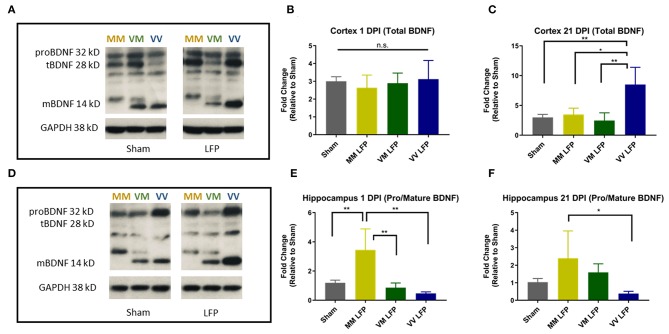
Repeated mild LFP injury causes an increase in proBDNF/mature BDNF expression in Met carriers compared to Val carriers in the hippocampus at 1 and 21 DPI. (A,D) Representative Western Blot showing pro and mature BDNF expression in the hippocampus after injury. Each lane represents one animal. (B,C) Quantification of protein levels in the cortex at 1 DPI and 21 DPI and (E–F) hippocampus at 1 DPI and 21 DPI. All data is first normalized to GAPDH to control for protein loading and then expressed as a fold change relative to the average ± SEM of the time matched sham controls which are represented as a single bar in the graph. *p ≤ 0.05, **p < 0.01, ANOVA Fisher's PLSD post-hoc test relative to indicated groups, n = 4.